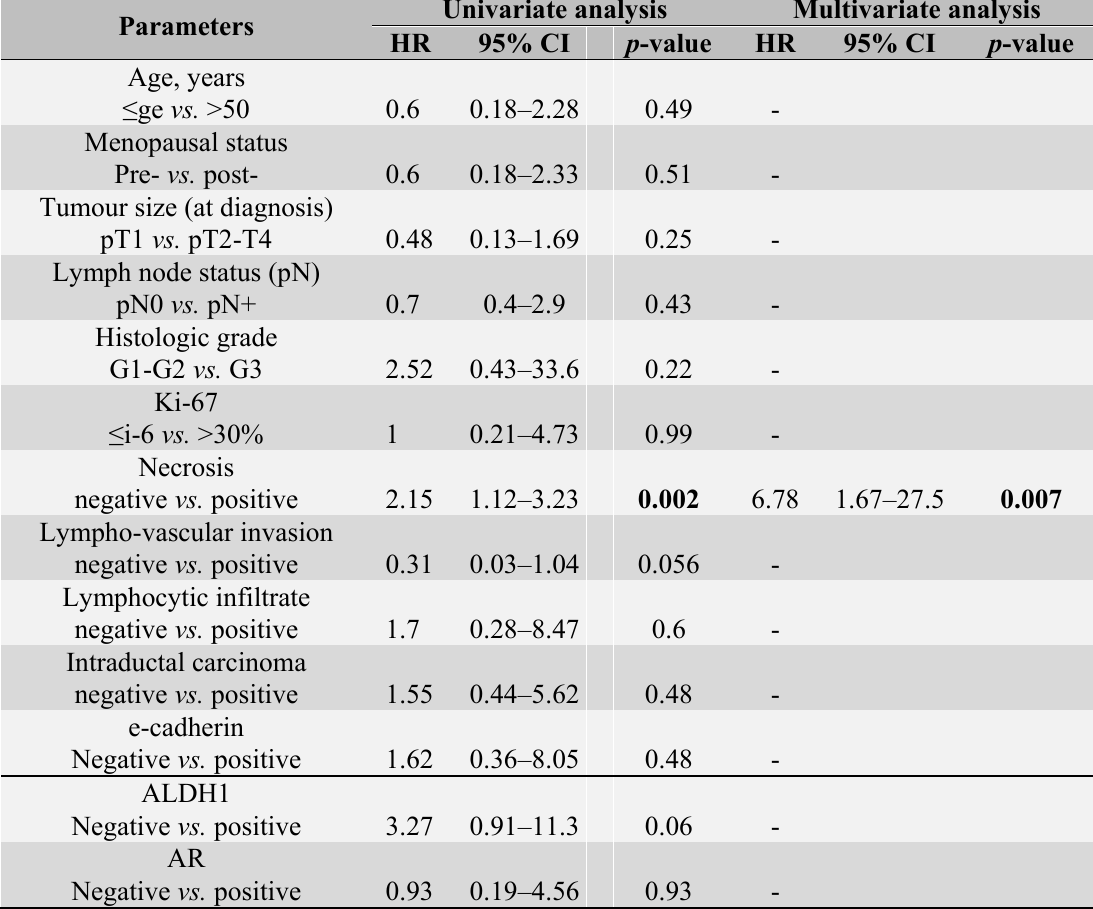
Table 3. Univariate and multivariate Cox regression analysis of factors associated with overall-survival in early triple negative breast